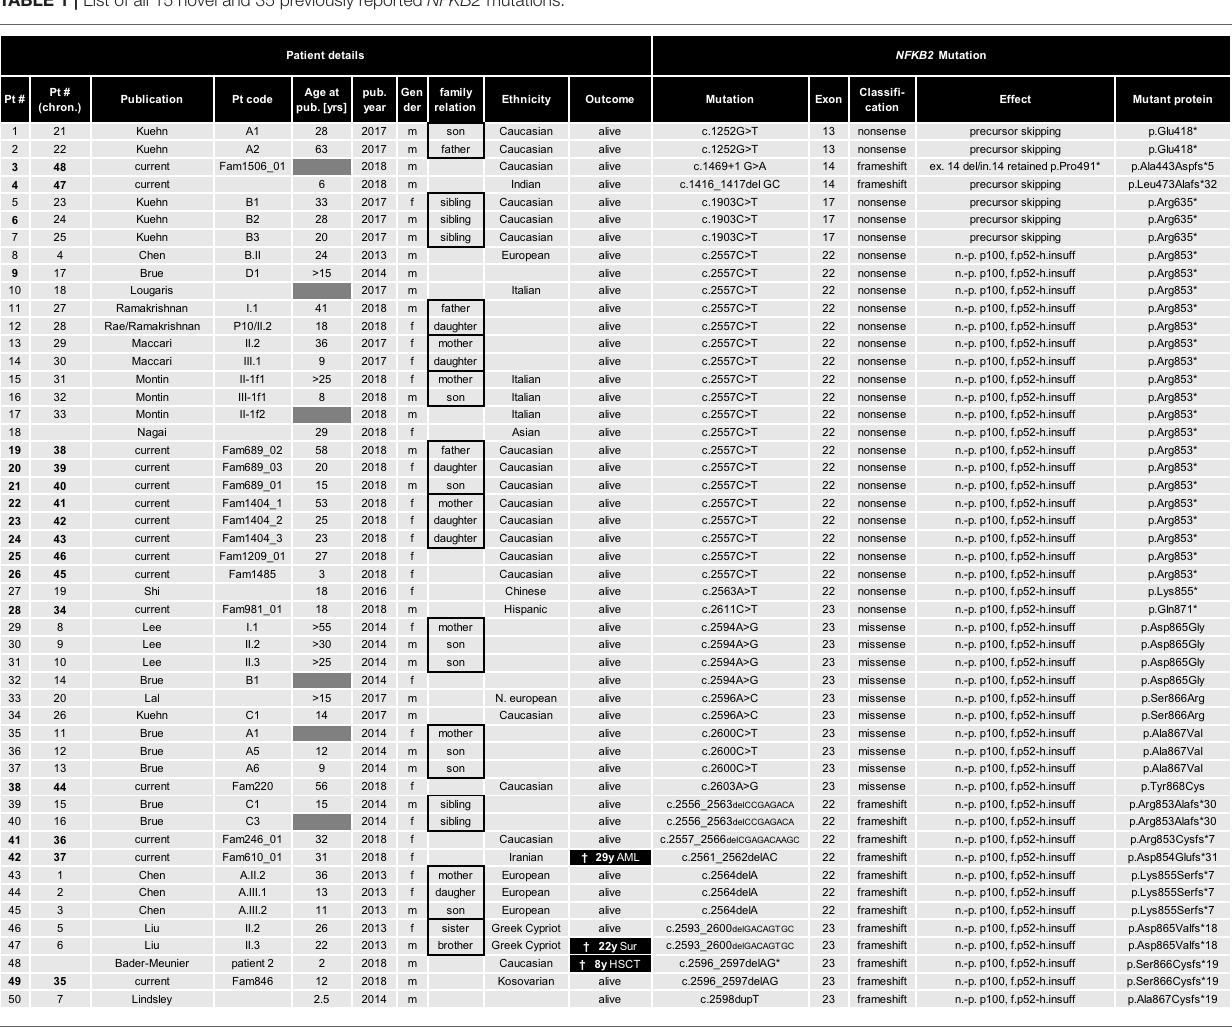
TABLE 1 | List of all 15 novel and 35 previously reported NFKB2